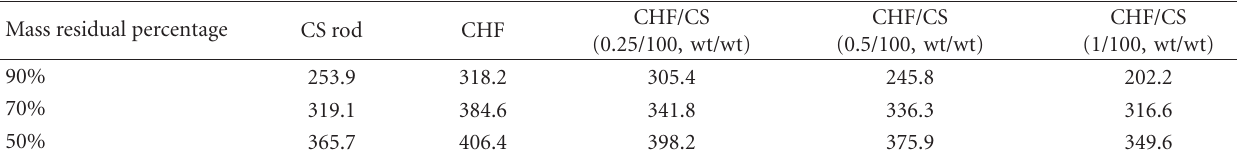
Table 1: The temperatures about mass residual percentage of samples (/ ◦ C